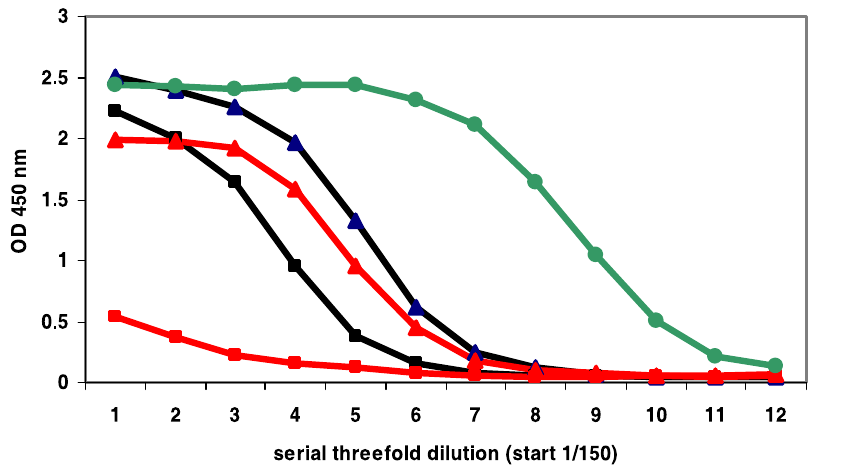
Figure 2. Binding of anti-cyclopeptide antibodies to oligomeric amyloid b (A b ) as determined by ELISA. Threefold serial dilutions (starting from 1/150) of pooled antisera obtained were tested. Antisera were raised by immunization with oligomeric (black m ) or fibrillar (black & ) A b (1–42) and TTd-conjugates of cyclo[A b (22–28)-YNGK 9 ] (red m ) or linear K 9 -A b (22–28)-YNG (red & ). Monoclonal antibody 6E10 (green control. Antibody binding to fibrillar A b (1–42) gave comparable results.